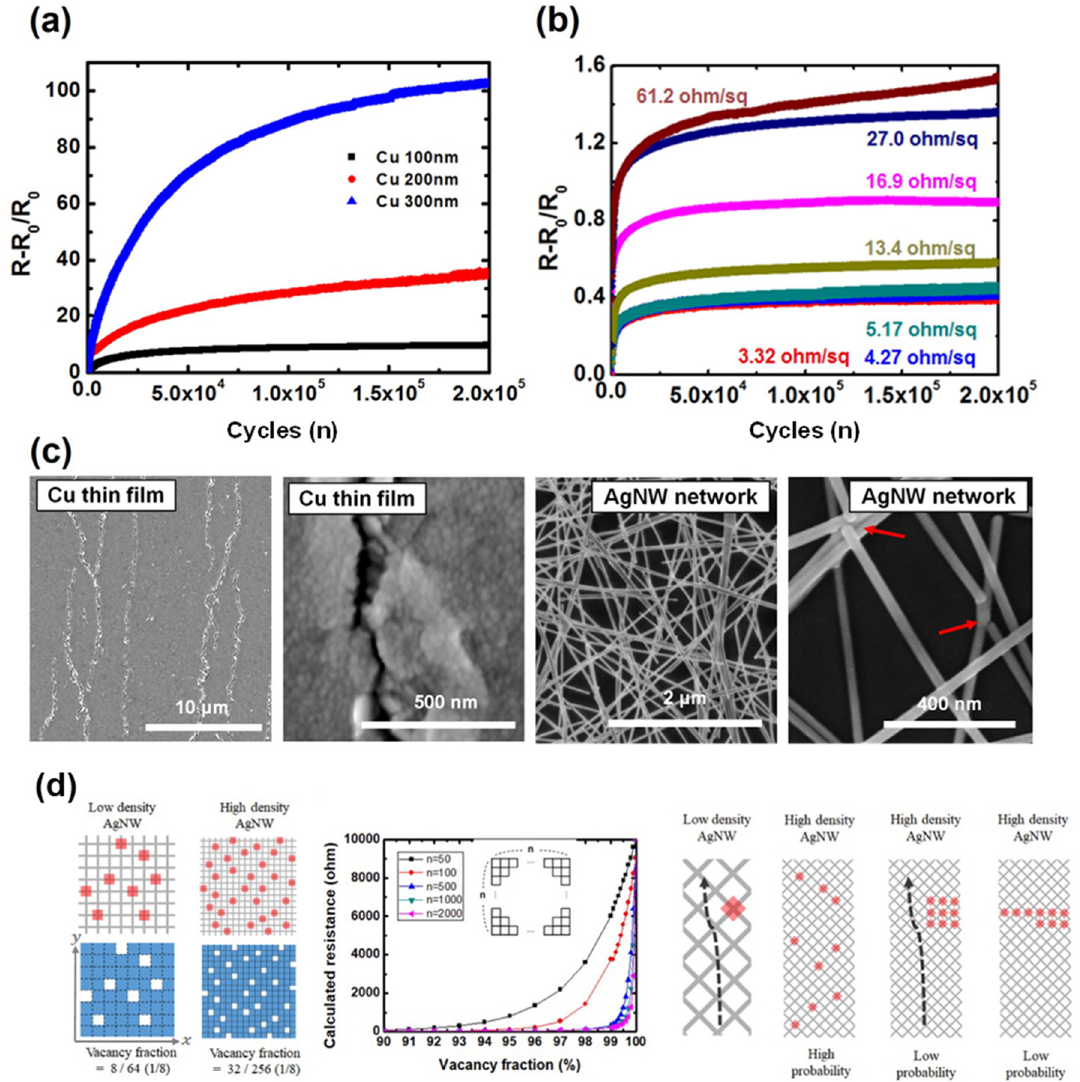
Figure 8. Resistance change of ( a ) copper thin films with different thicknesses and ( b ) silver nanowire networks with different density. ( c ) Low-magnification and high-magnification SEM images of copper thin films and silver nanowire network after the cyclic bending test. ( d ) Numerical calculation of change in the resistance of low-density and high-density silver nanowire networks, using the finite element method. Reproduced with permission from ref. [42]. Copyright 2019, Elsevier.